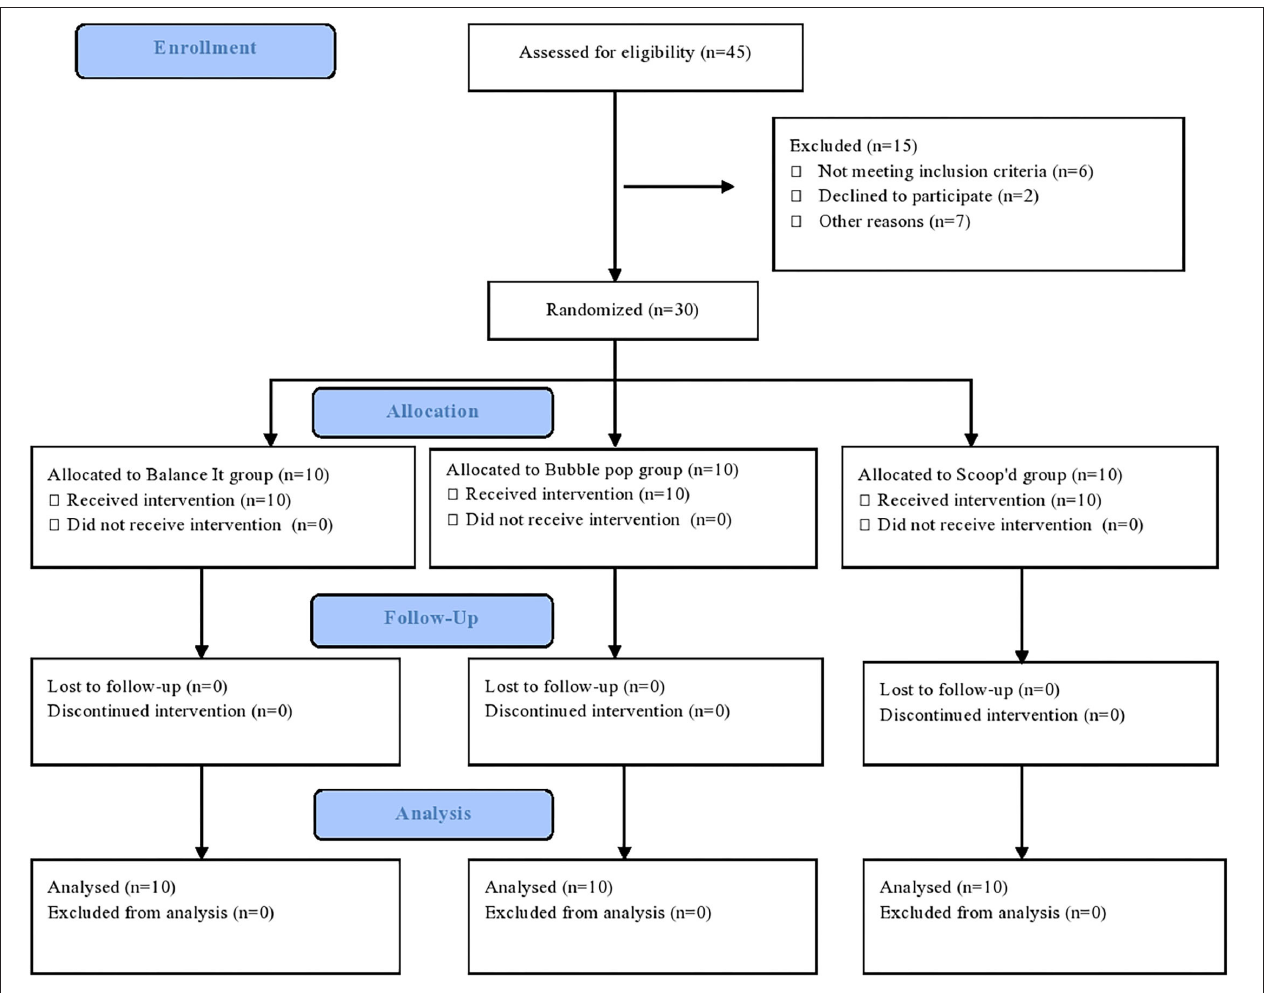
FIGURE 1 | CONSORT